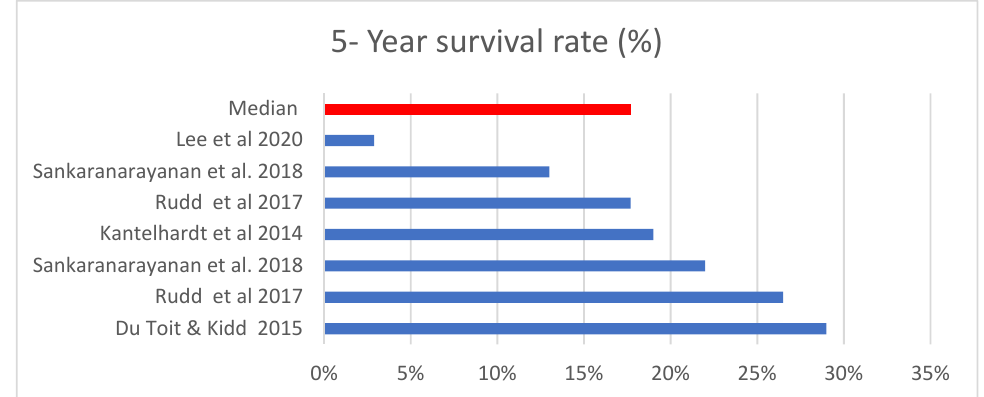
Figure 3. Cervical cancer mortality rate. Sources: [8,11,40,42–45]. Survival rates ranged from 13% to 29% with a median of 17.7% from 7 studies. The statistics are displayed in Figure 4.